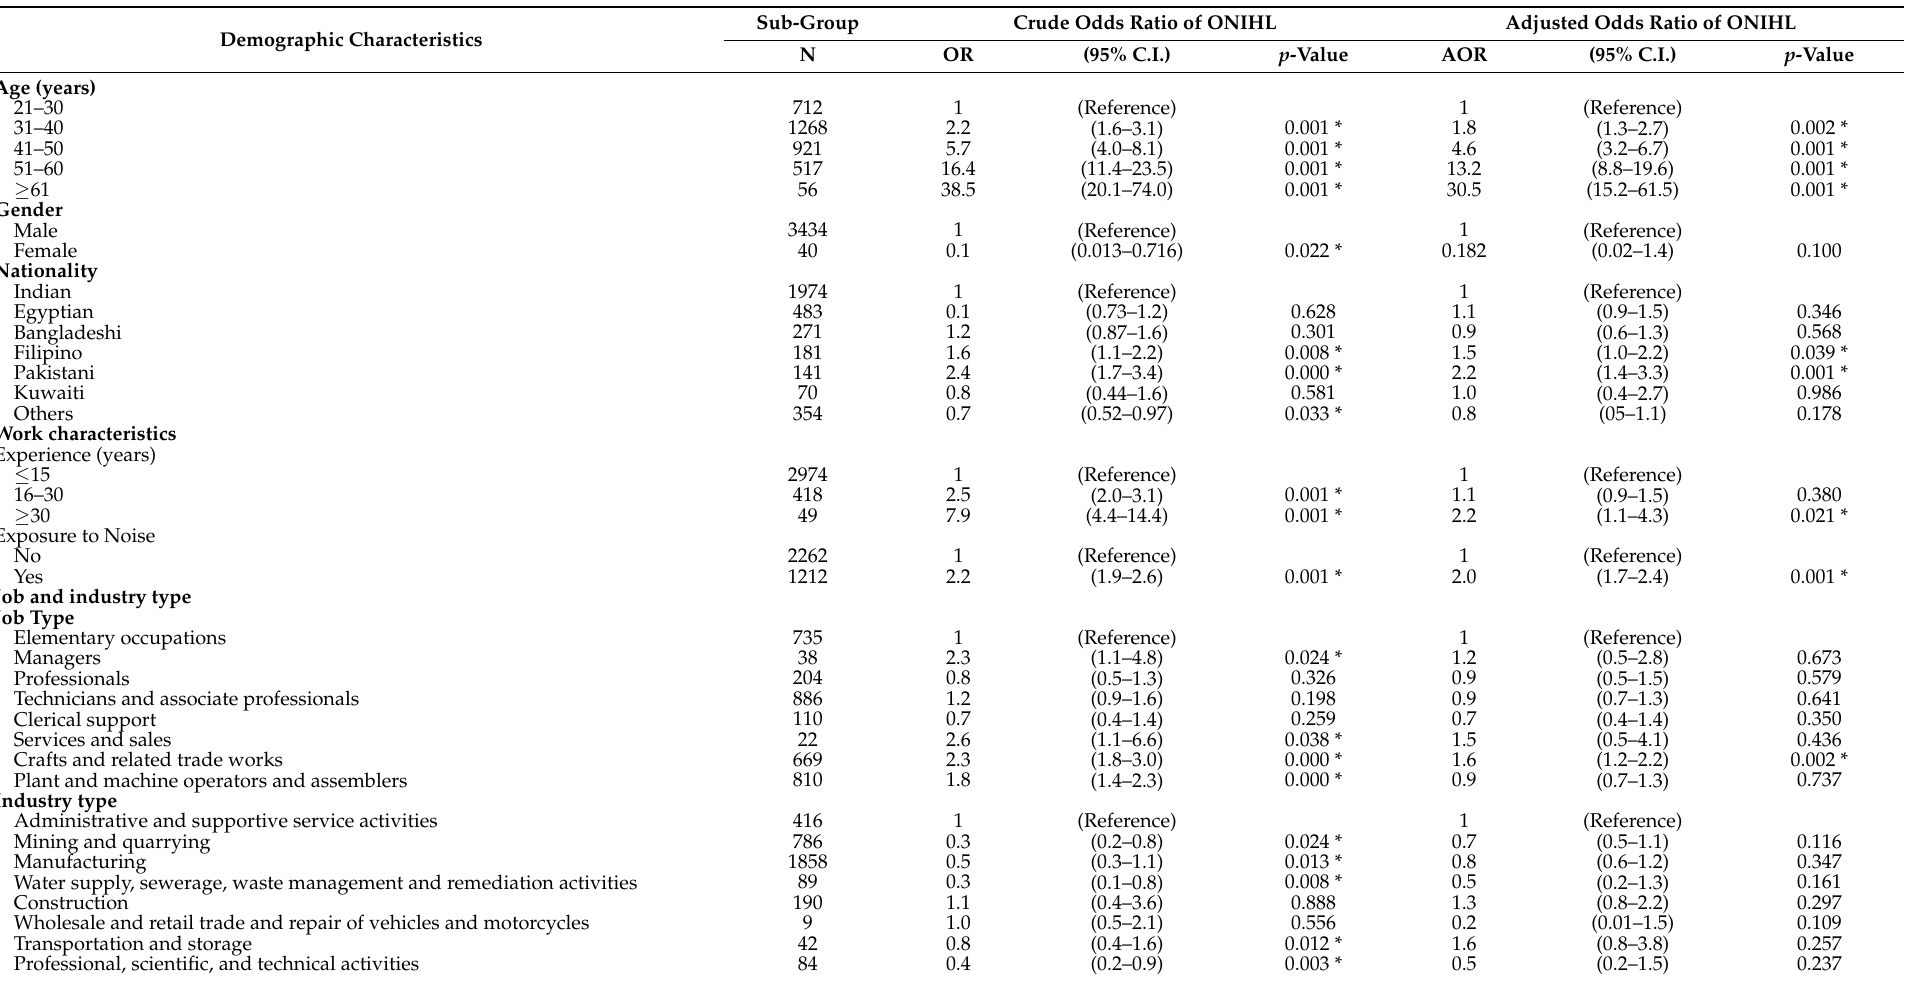
Table 3. Crude and adjusted odds ratios of occupational noise-induced hearing loss among 3474 industrial workers. Demographic